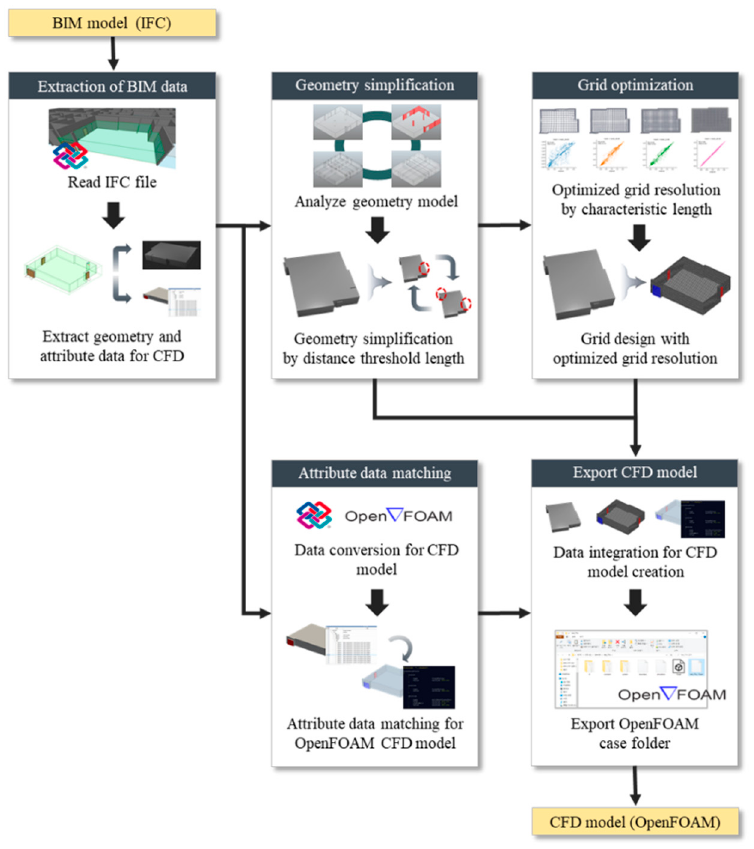
Figure 1. Design process of optimized Computational Fluid Dynamics (CFD) model using Building Information Modelling (BIM). IFC, Industry Foundation Classes.